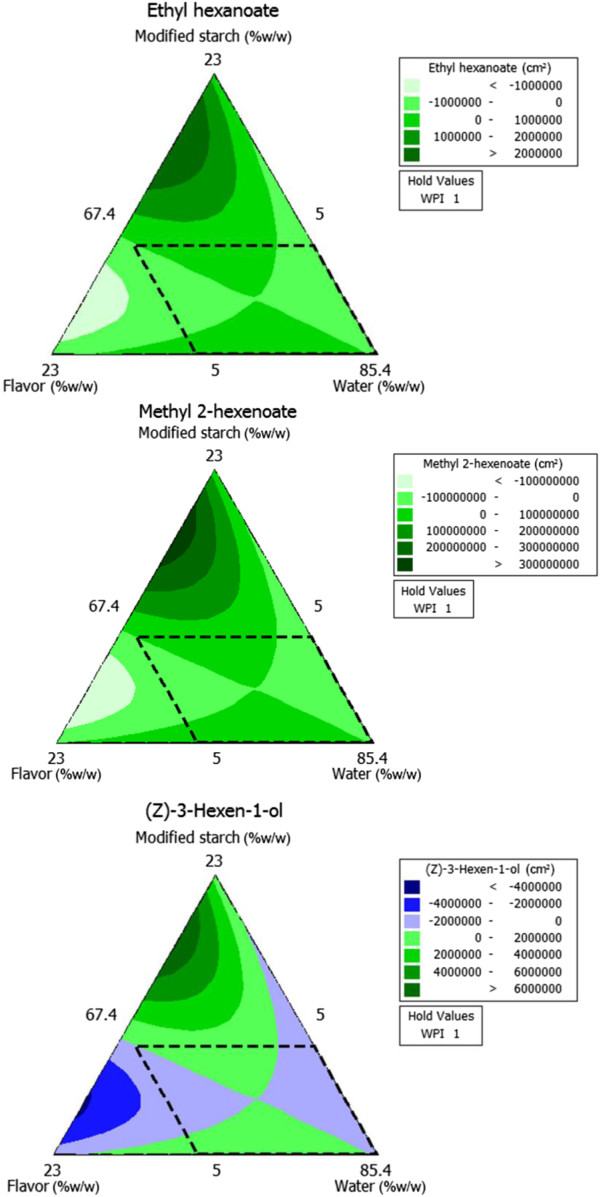
Mixture contour plots of three soursop flavor compounds. Diamond-shaped subregion is the constrained experimental region.